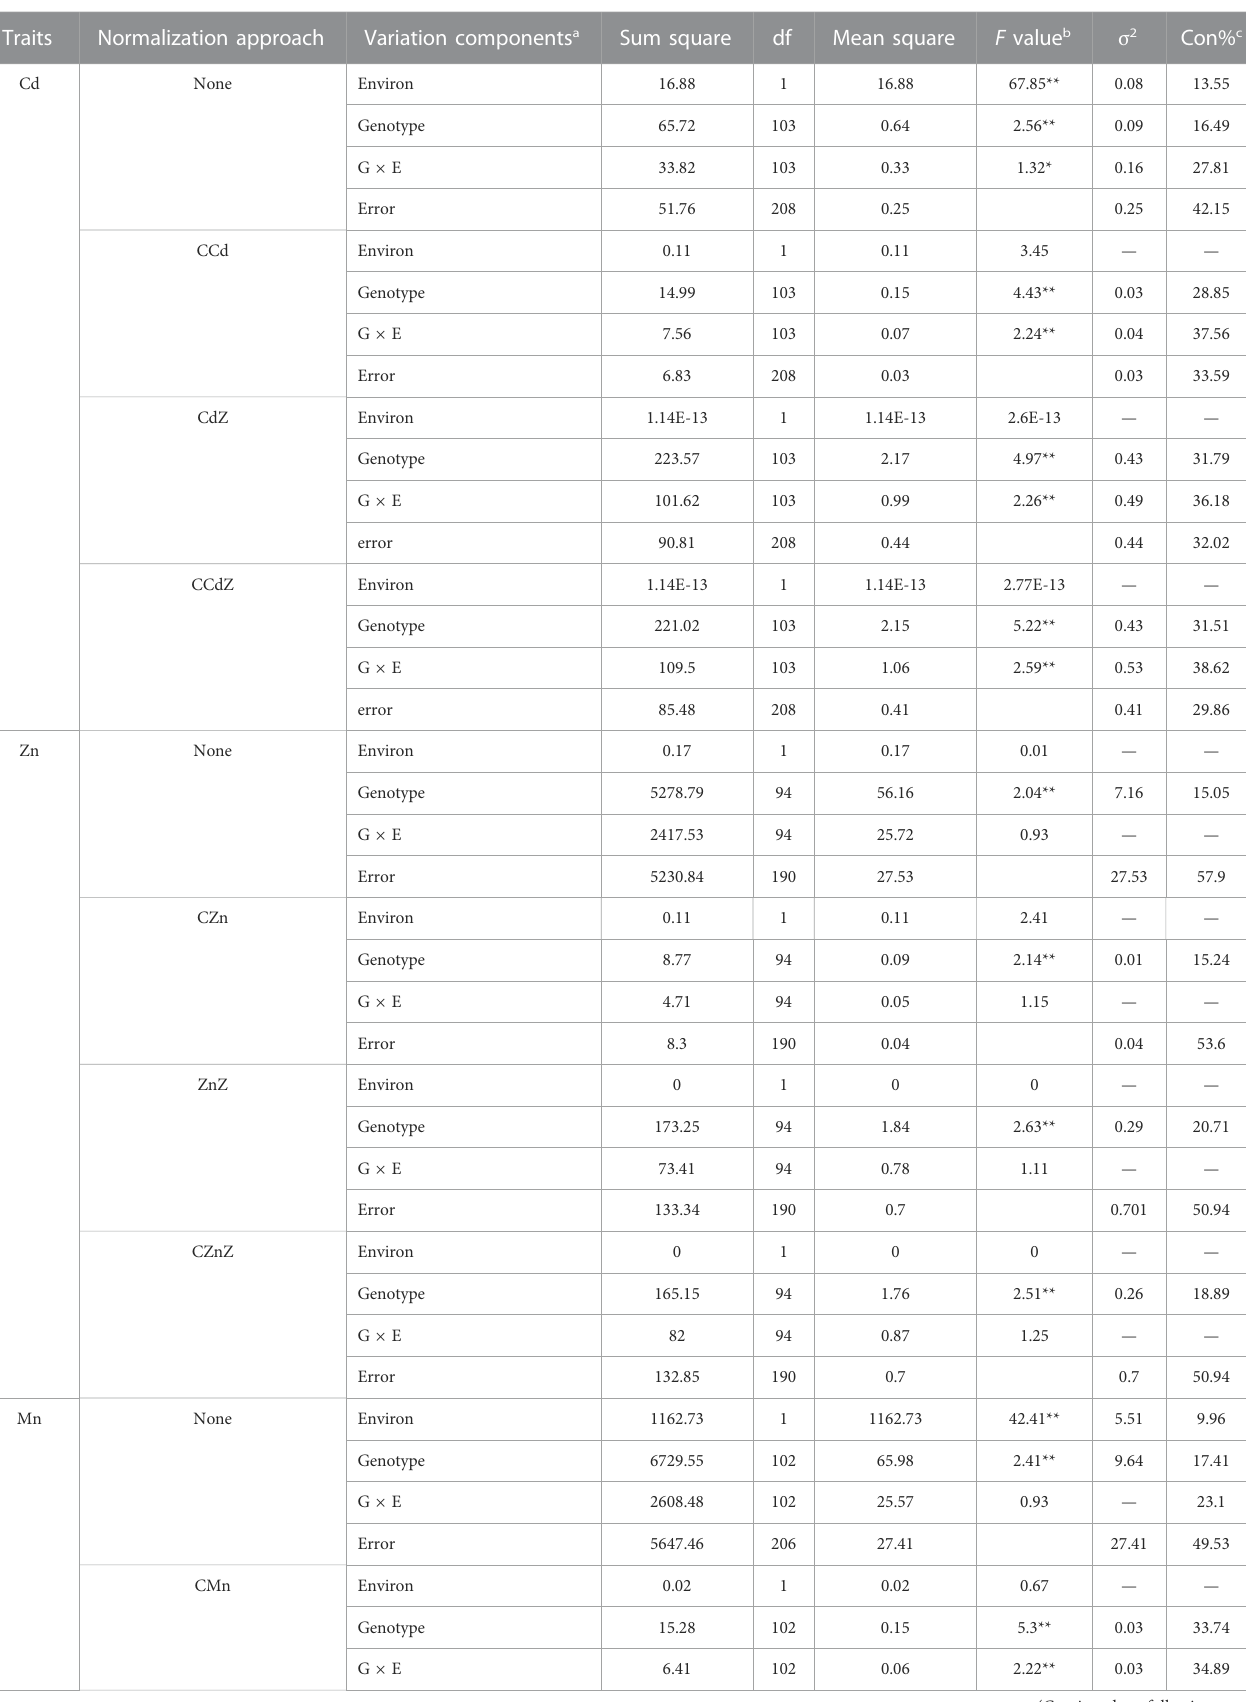
TABLE 1Thephenotypiccomponentsanalysis usingtwo-way ANOVA for grain-Cd, grain-Mn, andgrain-ZnperformanceinPop6grown intwo Cd-contaminatedpaddy fi elds.